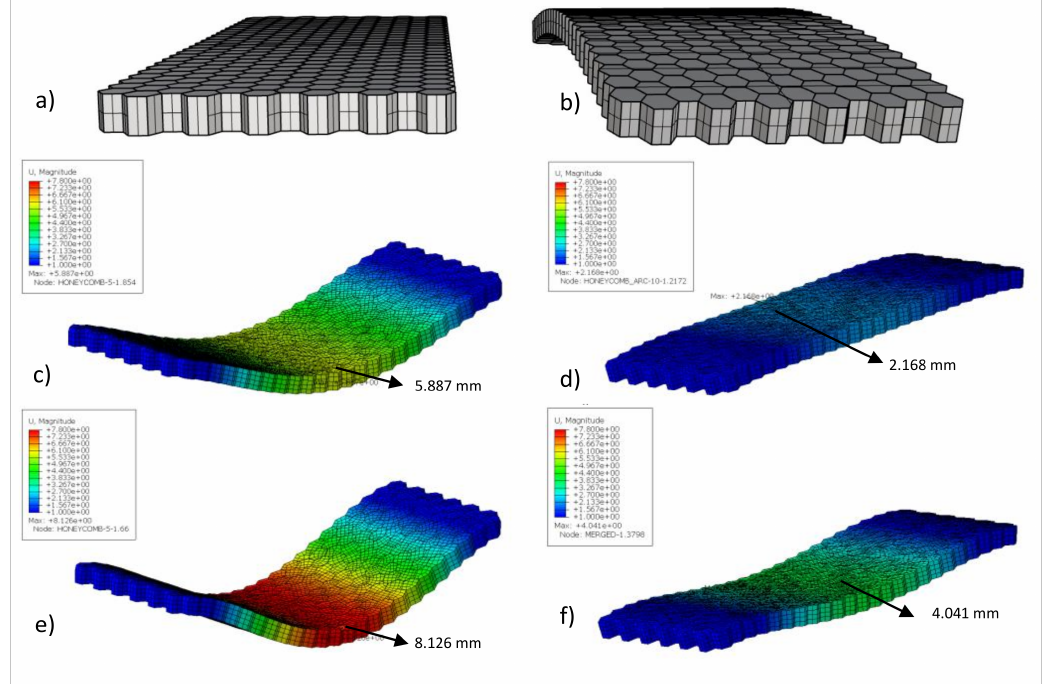
Figure 10. Geometry of sandwich panel with: ( a ) honeycomb cell configuration and ( b ) honeycomb cell configuration in an arch. Deformation for sandwich panel with: ( c ) honeycomb cell configuration (laminate); ( d ) honeycomb cell configuration (laminate) in an arch; ( e ) honeycomb cell configuration (quasi-isotropic); ( f ) honeycomb cell configuration (quasi-isotropic) in an